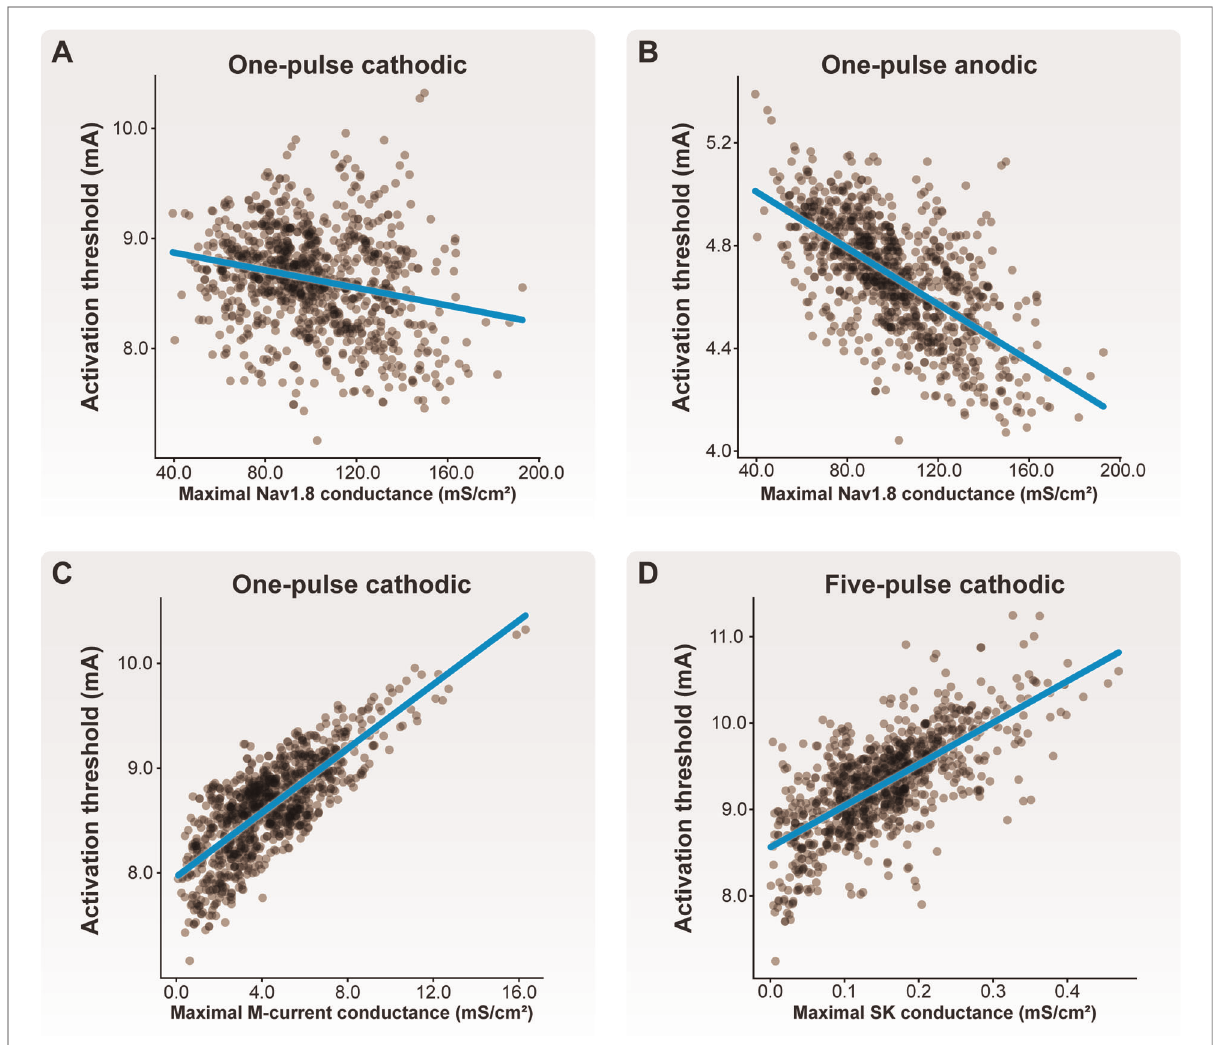
FIGURE 7 Correlations between biophysical parameters and activation thresholds. Each brown point corresponds to an individual model C-neuron. Each blue line corresponds to the linear least-squares regression. Both ( A ) cathodic- fi rst and ( B ) anodic- fi rst activation thresholds were negatively correlated with maximal Nav1.8 conductance. ( C ) Cathodic- fi rst thresholds were correlated with maximal M-current conductance. ( D ) Five-pulse cathodic- fi rst thresholds were correlated with maximal SK